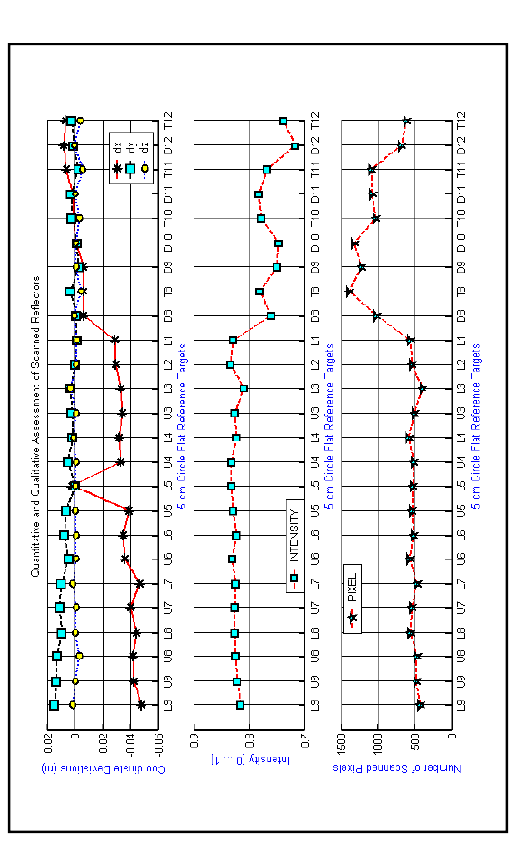
Figure 4: Accuracy (top), intensity (middle), and density (down) of the target points at Station 1